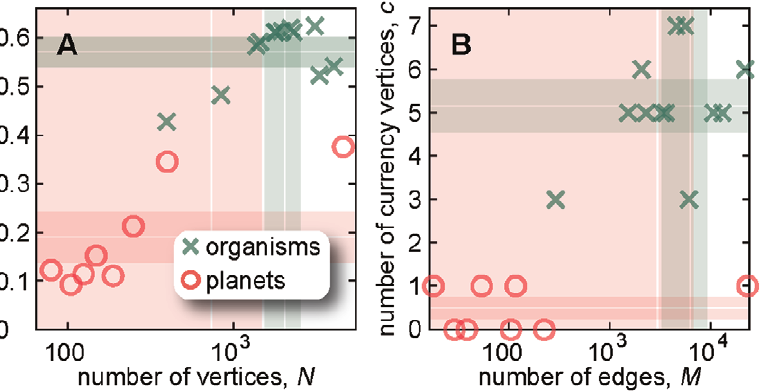
Figure 4. Relative modularity and the number of currency vertices separate networks of metabolism from networks of planetary atmospheres more than their sizes do. To show that the maximal relative modularity separates metabolism from reaction systems of planetary atmospheres, we display (panel A) the relative modularity D as a function of the number of vertices N . The shaded areas indicate the standard deviation and means of the respective quantities. Similarly, in B, we show another quantity related to the functional organization, the number of currency vertices c , as a function of the number of edges M in the network. Note that axes are linear and logarithmic respectively.